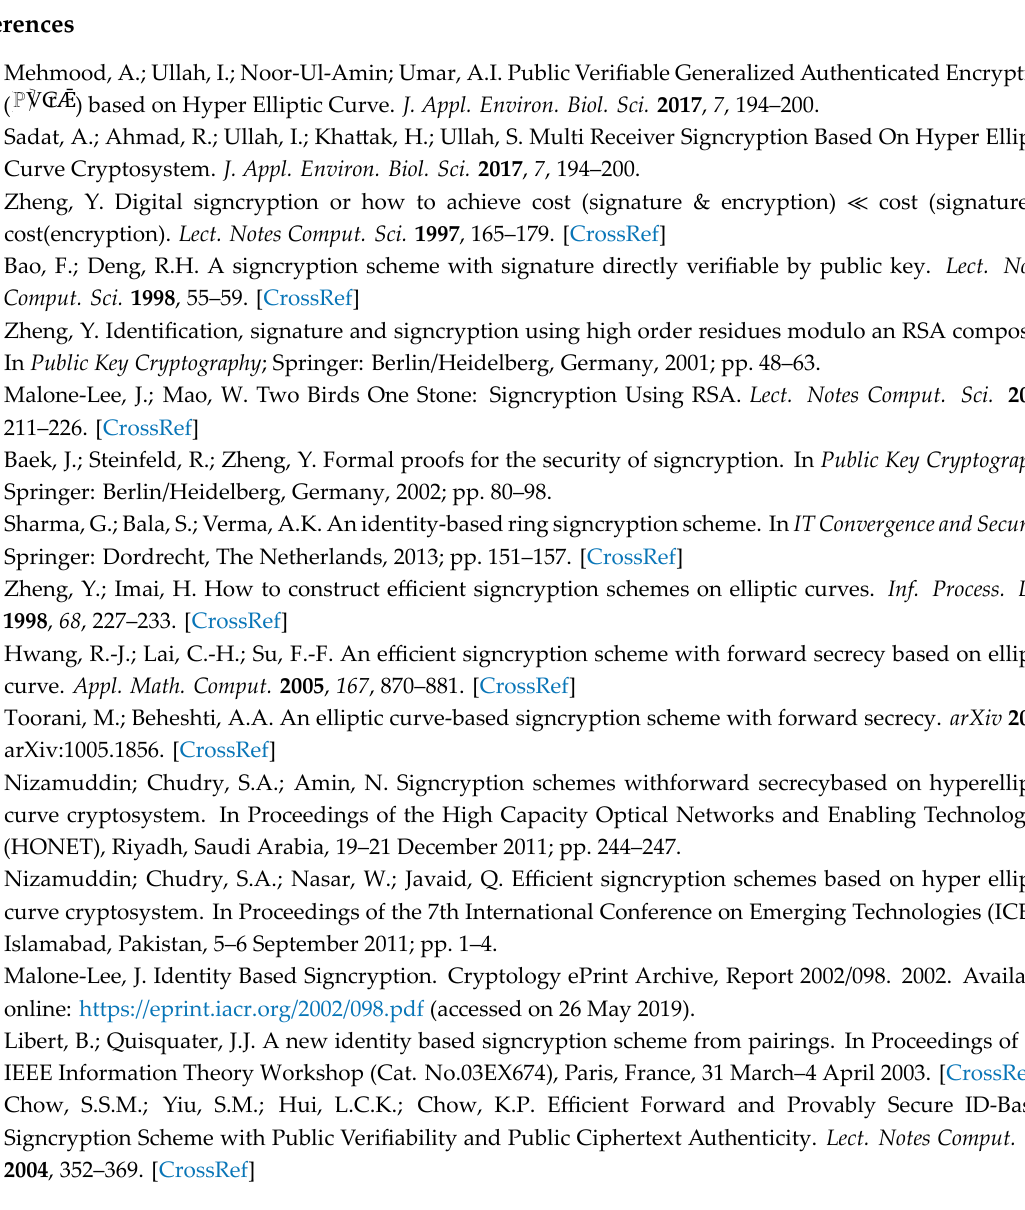
Figure A2. ATSE simulation results.